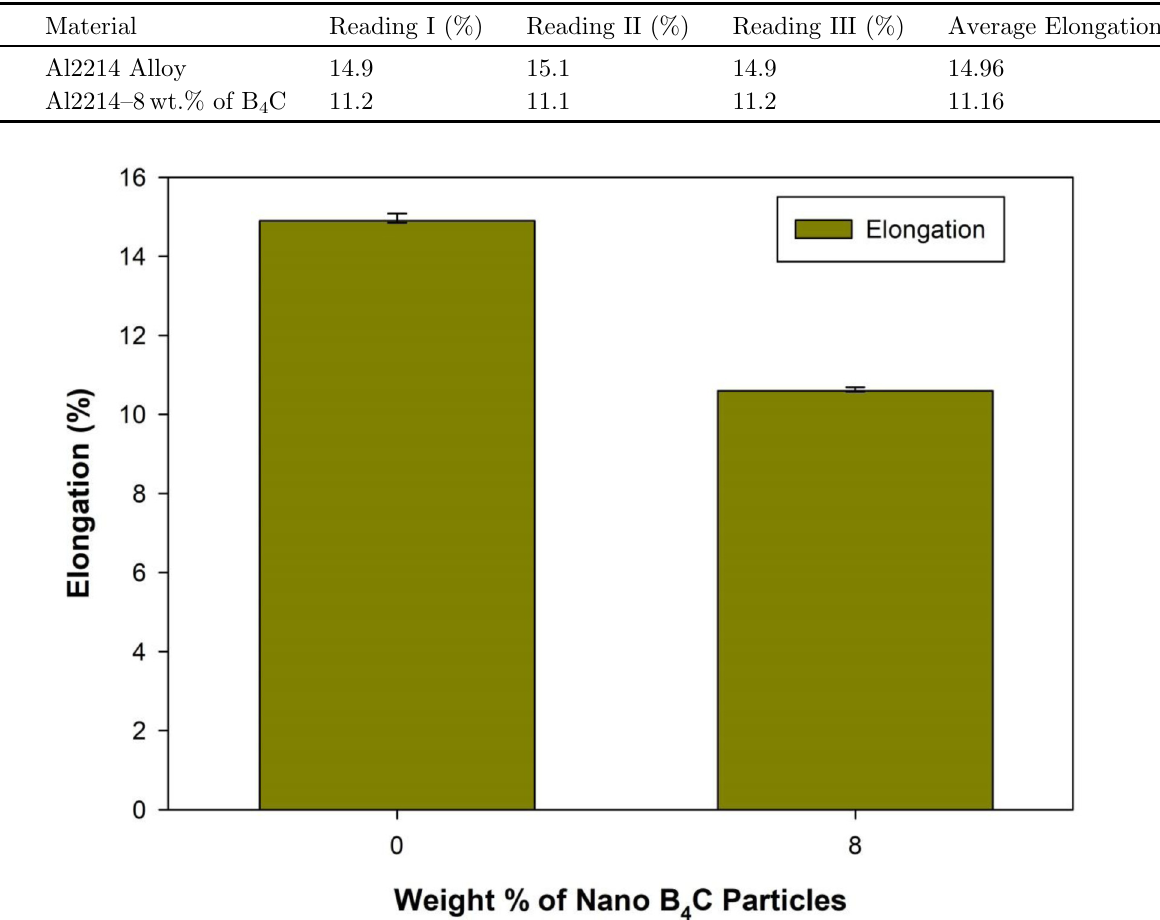
Fig. 11. Ductility of Al2214 alloy and its composites.